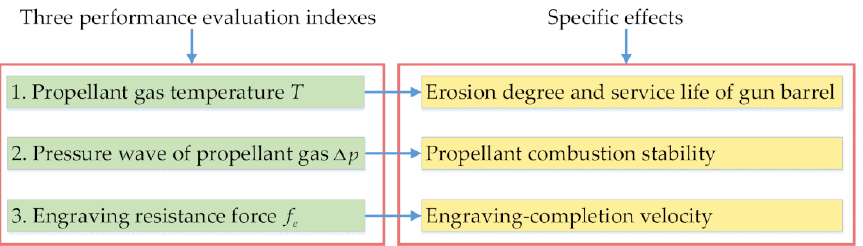
Figure 8. Three performance evaluation indexes and their corresponding physical